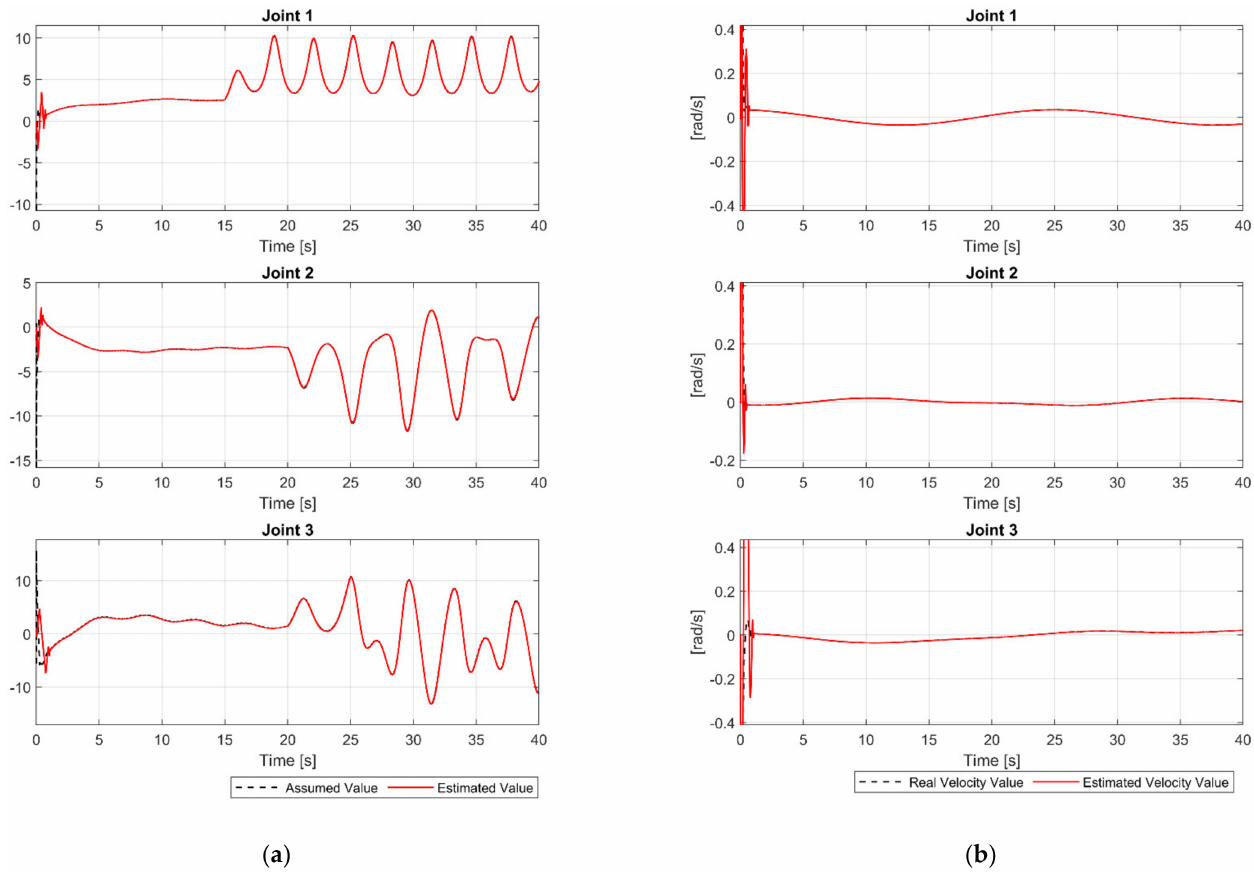
Figure 8. ( a ) The assumed value of uncertainty and fault, and its estimated value at joints; ( b ) the real velocity value and its estimated value at